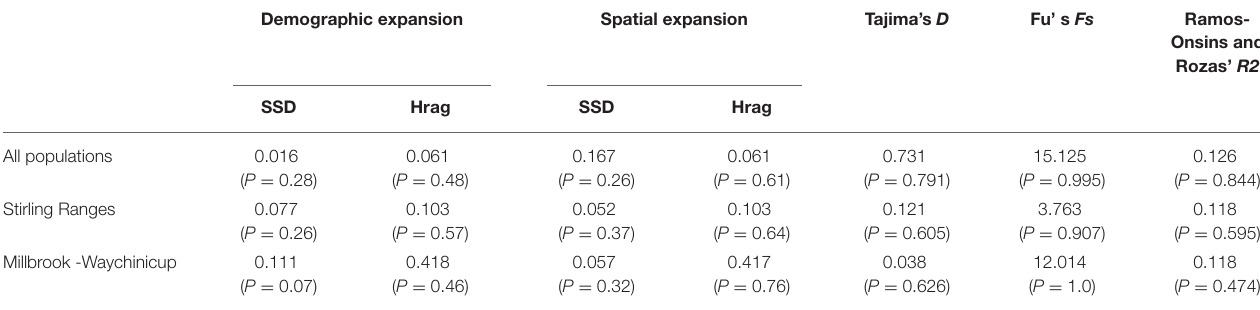
TABLE 3 | Results of neutrality tests and mismatch analysis for populations and regions of Banksia brownii assayed with three chloroplast